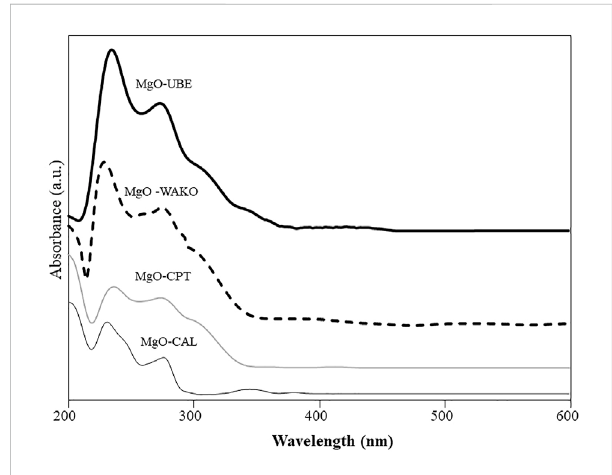
FIGURE 8 Diffuse re fl ectance UV-Vis spectra of different MgO catalysts.